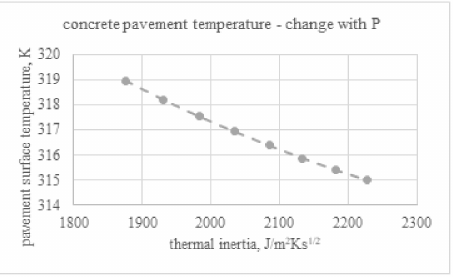
Figure 11. Asphalt pavement surface temperatures with changing thermal inertia